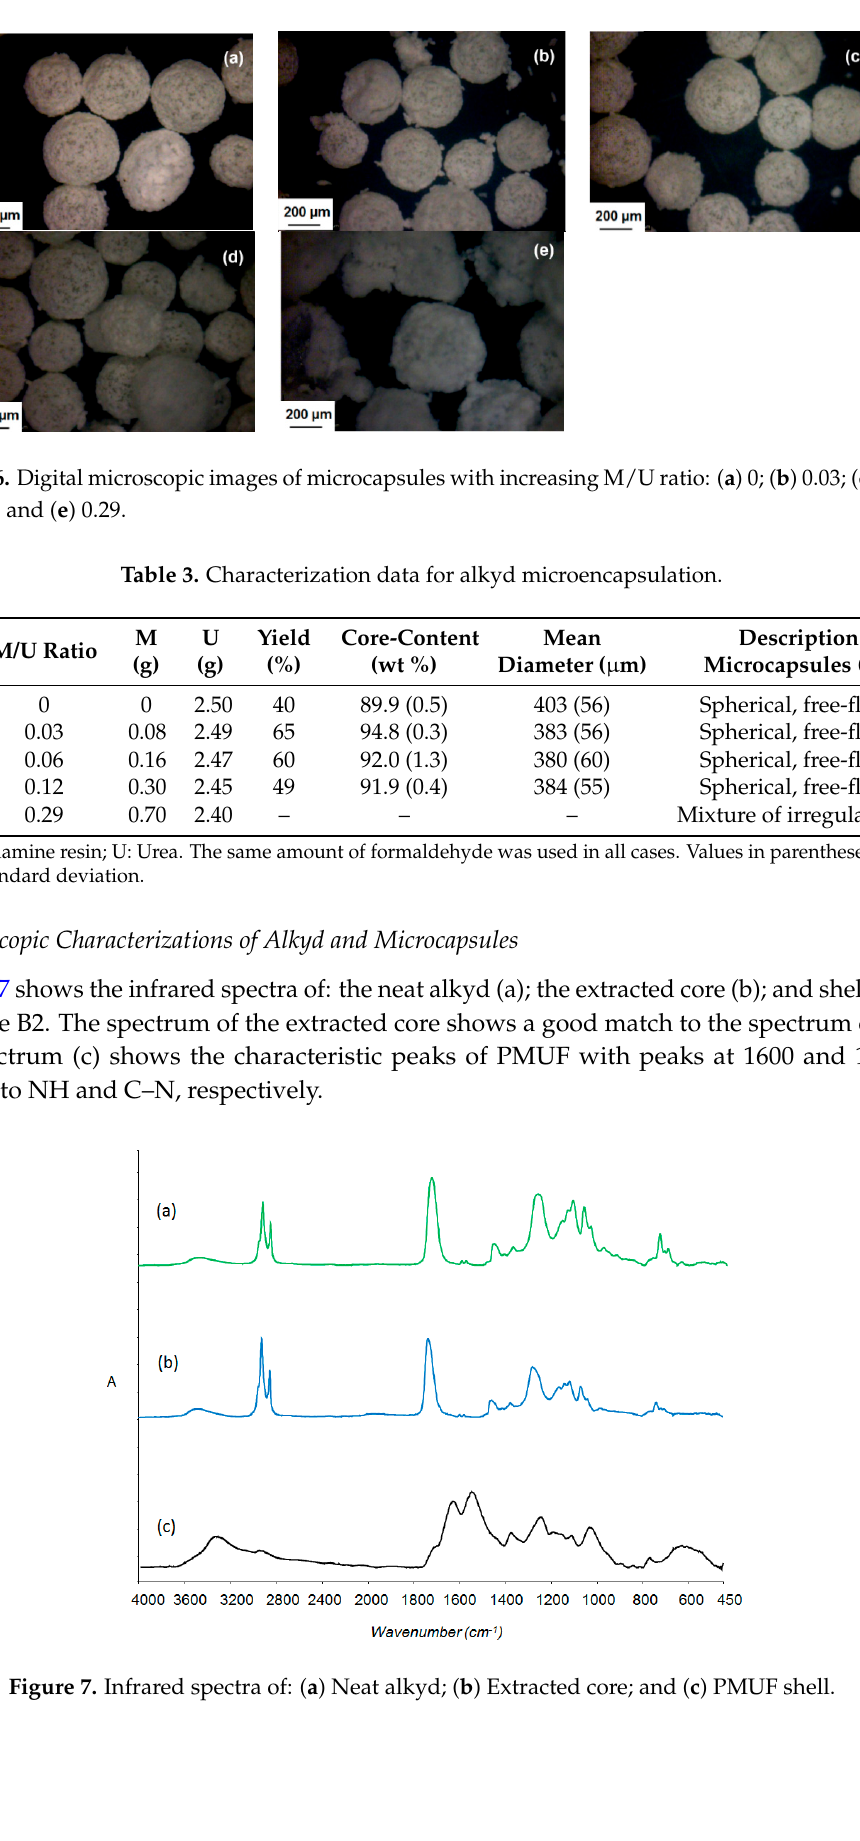
Figure 8. 1 H-NMR spectra of extracted core of sample B2. 3.5. Thermal Analysis Figure 9 shows the DSC thermograms of samples A2 and B2 compared to the neat alkyd and shell materials. Both samples show glass transition ( T g ) and melting ( T m ) peaks, which correspond to the T g and T m of the encapsulated alkyd. The T g of A2 and B2 were − 13.0 and − 11.6 °C, respectively, while the T g of the neat alkyd was − 13.2 °C. The slightly higher T g of B2 indicated the possibility of some reactions between the melamine resin with the –OH group on the surface of the alkyd droplet. Similar to the neat alkyd, A2 and B2 showed broad melting peaks area 0–15 °C. At the higher temperature range, A2 and B2 exhibited melting peaks of the shells at 148 and 192 °C, which